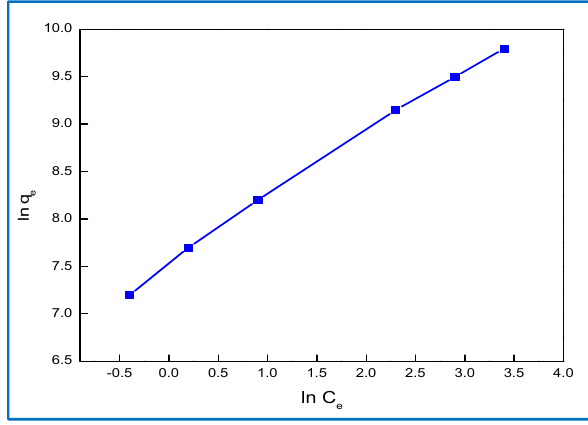
Figure 11. Freundlich adsorption for 20 mg · L − 1 BG dye removal on 0.9 g · L − 1 Hap/CS.